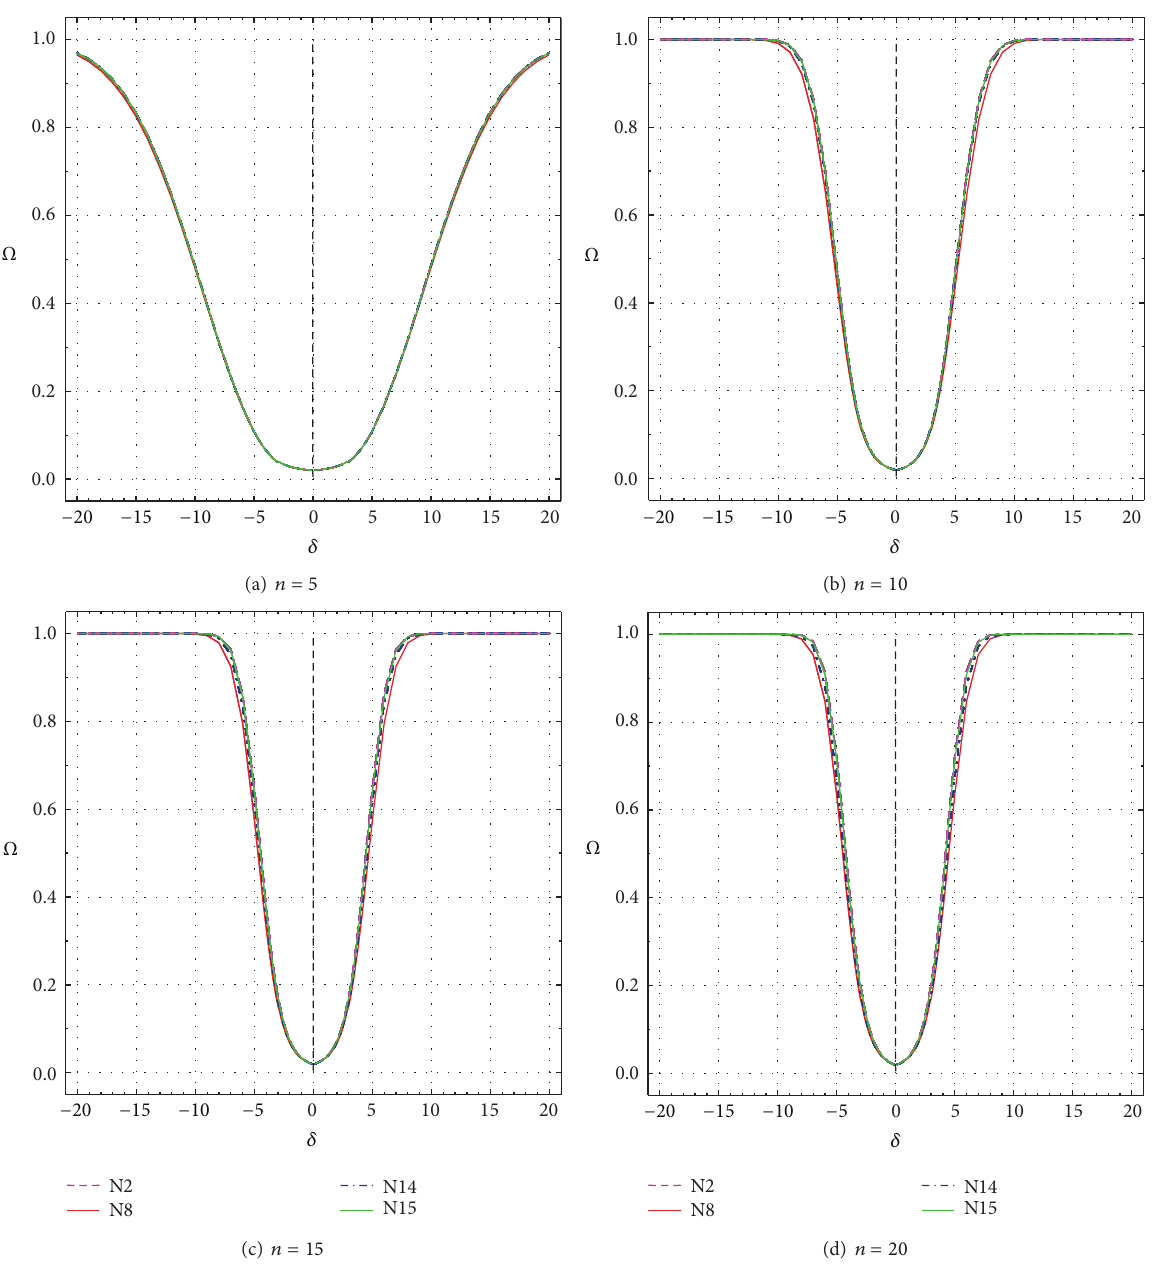
Figure 9: Power of Test ( Ω ) as a function of 𝛿 from − 20 to +20 for all tests N2, N8, N14, and N15. (a) 𝑛 = 5 ; (b) 𝑛 = 10 ; (c) 𝑛 = 15 ; and (d) 𝑛 = 20